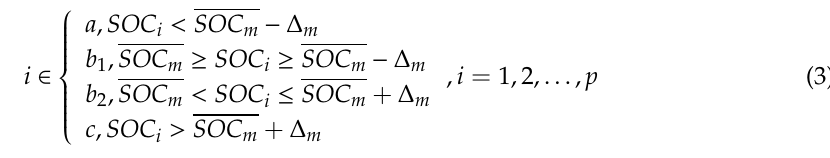
Figure 8. Partition and equalization path sketch maps. ( a ) Batteries partition sketch map, ( b ) equalization path of Case 1, ( c ) equalization path of Case 2, ( d ) equalization path of Case 3, ( e ) equalization path of Case 4, ( f ) equalization path of Case 5.